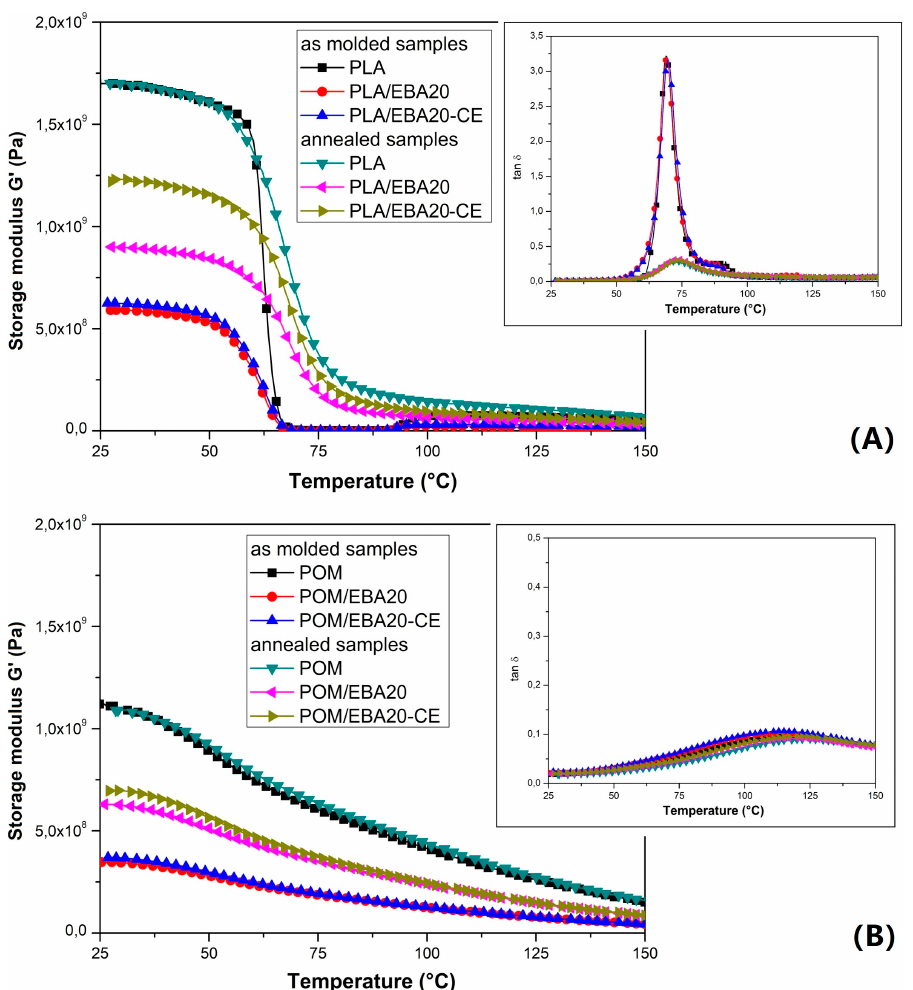
Figure 8. Storage modulus and tan δ thermograms for PLA- ( A ) and POM- ( B ) based samples modified with the E/BA/GMA elastomer and ESA chain extender. The plots include the thermograms of the “as-molded” and “annealed” samples.